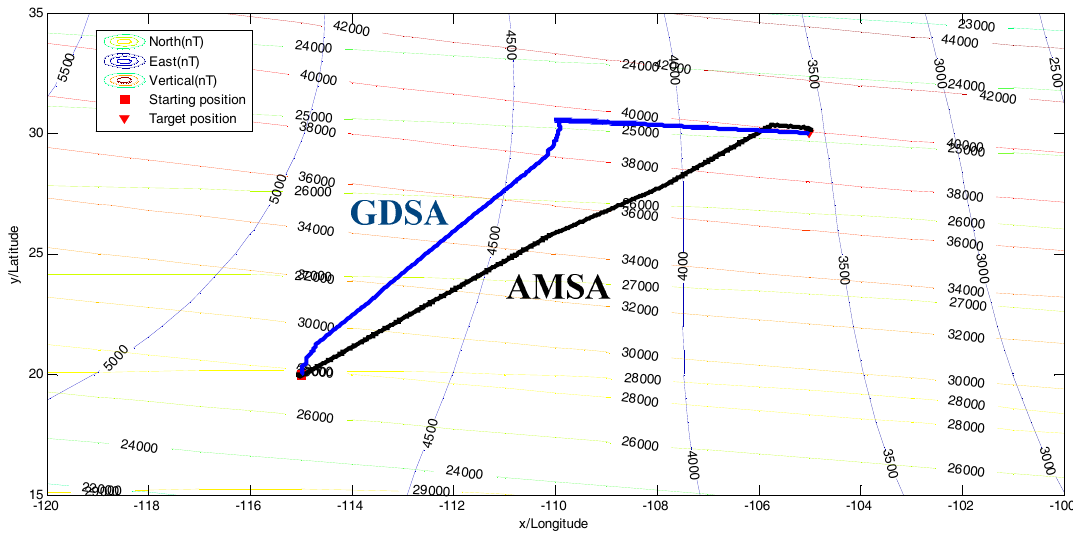
Figure 8. The search paths of two algorithms.